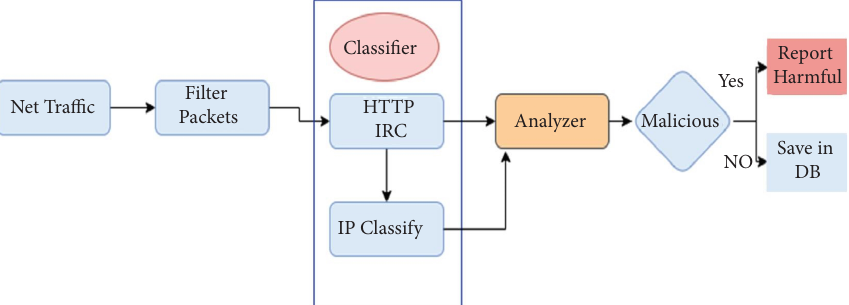
Figure 3: Architecture of the classifer.